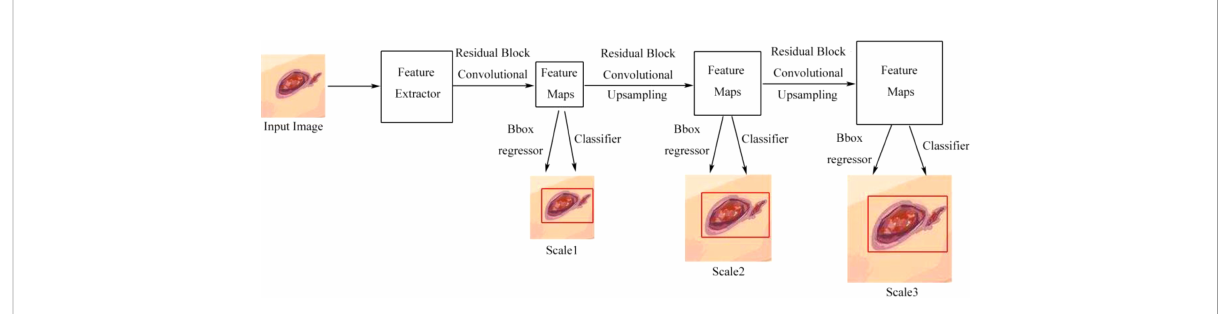
FIGURE 7 Detection fl ow chart of YOLO v3 without the region proposal process. Scale1, Scale2, and Scale3, respectively, represent the scale of detecting a small, medium, or large object